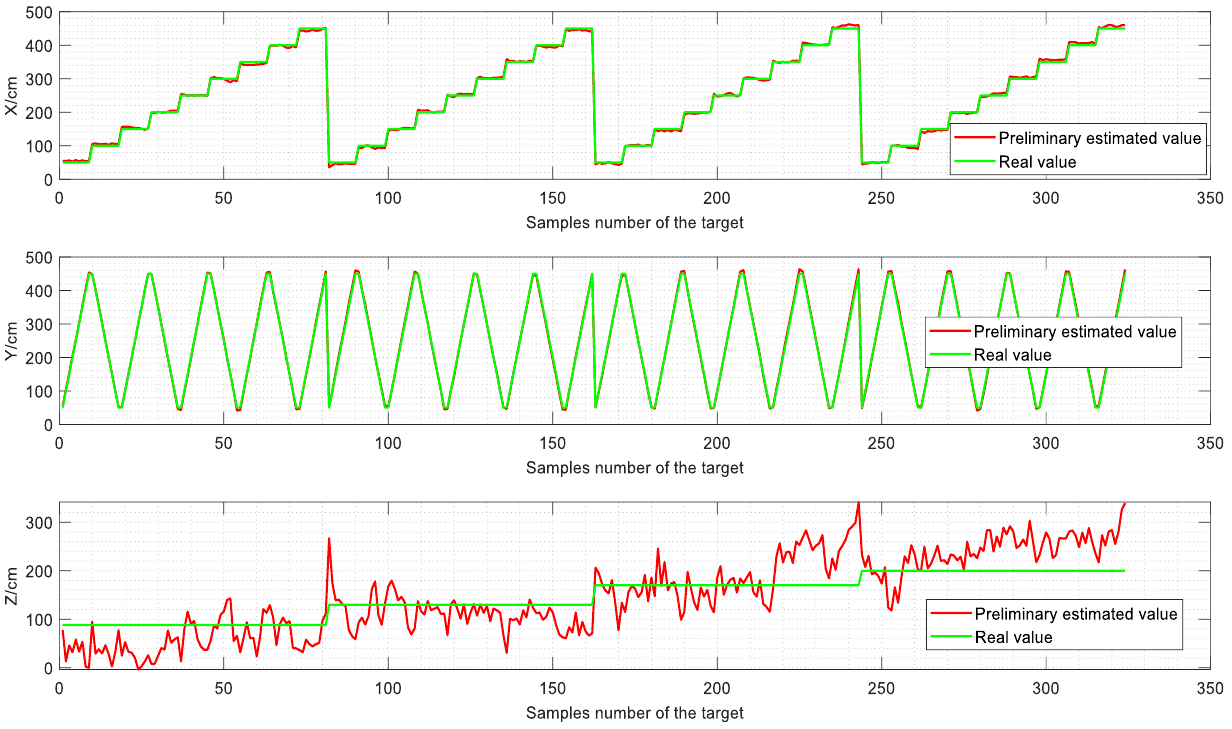
Figure 9. The comparison of the true value and estimated value of the target coordinates without signal interference.